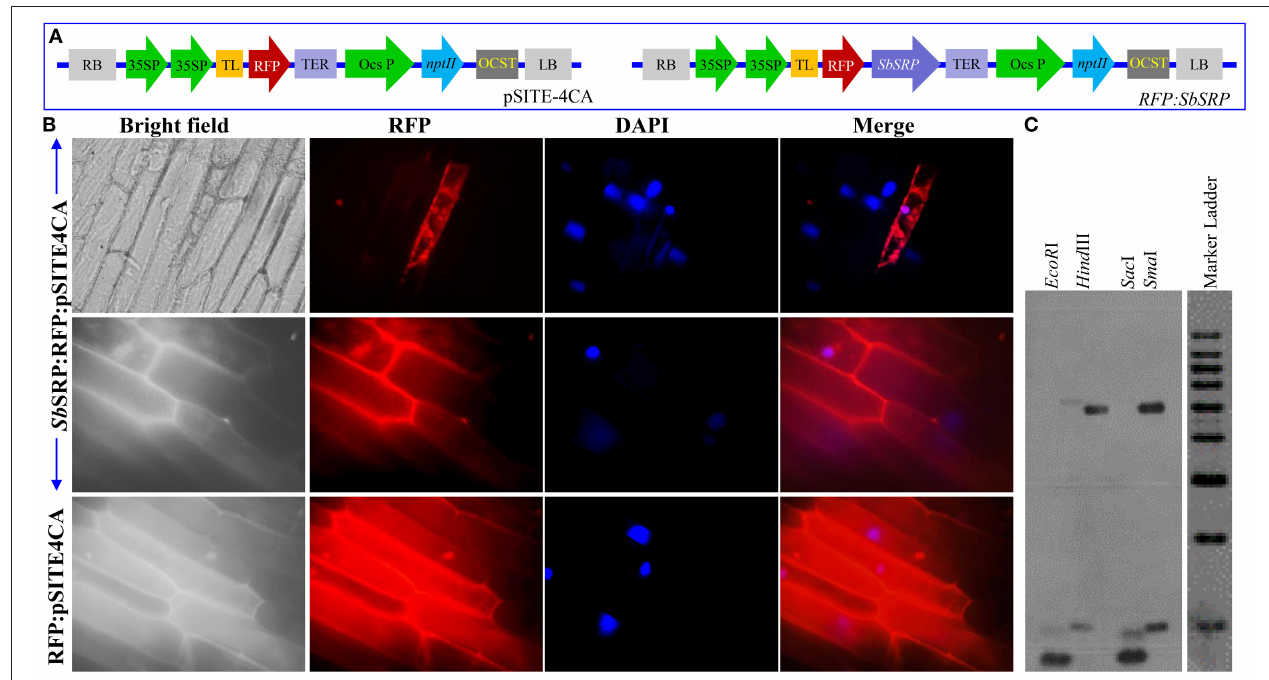
FIGURE 1 | Sub-cellular localization of Sb SRP protein and gene copy number. (A) Vector pSITE-4CA (RFP) and SbSRP-1:RFP gene construct, (B) Transient expression of RFP alone and Sb SRP:RFP translational fusion protein on transformed onion epidermal cells and (C) DNA hybridization of Salicornia brachiata genome to determine the copy number of SbSRP